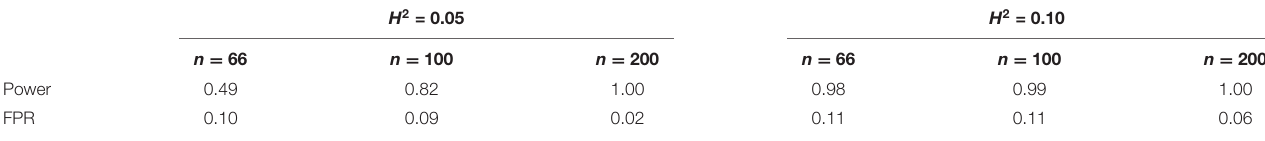
FIGURE 6 | Temporal pattern of the pleiotropic effect on stem height and diameter. The multiphasic genetic effects of stem (A) height and (B) diameter, and the dynamic relationship of each effect on the two growth traits (C) at SNP 137076. The blue solid line represents the total effect of multiphasic growth, the red solid line displays the effect of the first phase, and the purple solid line denotes the effect of the second phase. The first phase effect curve was divided into independent (red broken line) and interaction (red dotted line) curves. TABLE 2 | Mapping accuracy (power) and false positive probability (FPR) of quantitative trait loci (QTLs) based on the NGE. H 2 = 0.05 H 2 = 0.10